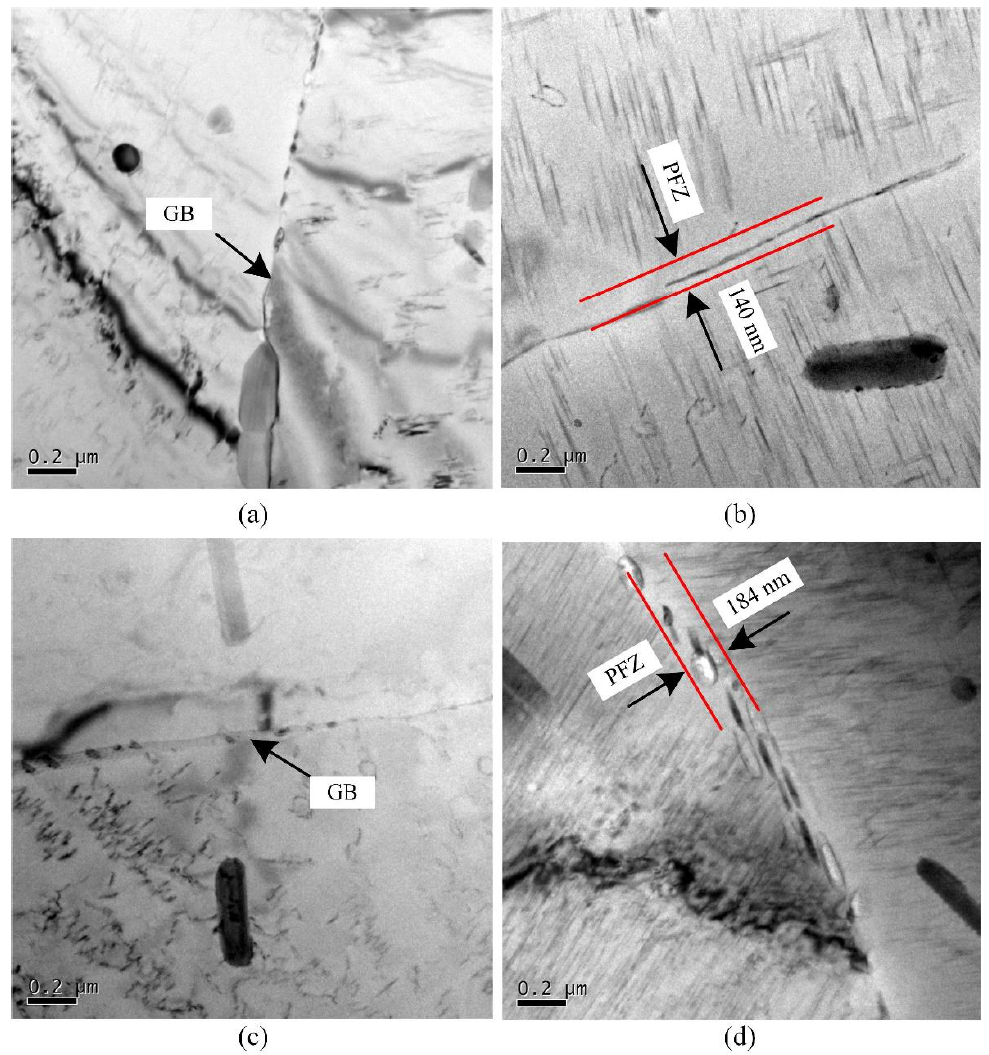
Figure 6. TEM images of AA2524 at the grain boundary under different treatment: ( a ) CAF-9h; ( b ) CAF-24h; ( c ) SFA-9h; ( d ) SFA-24h.